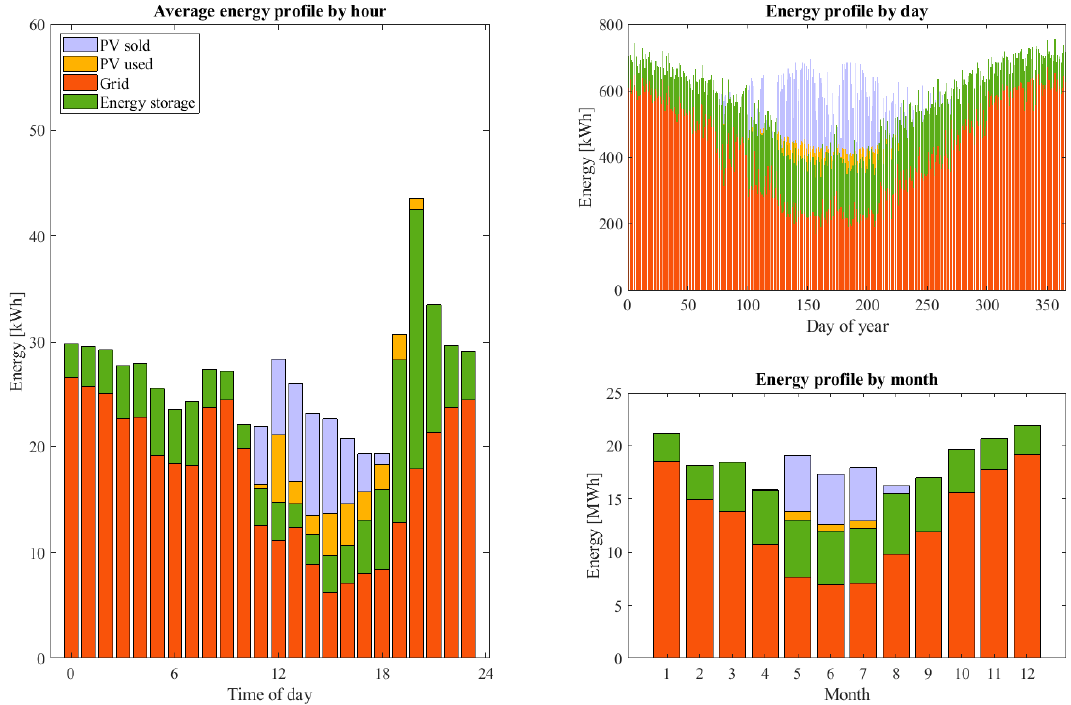
Figure 13. Average energy profiles by hour, day, and month in scenario 2.a.